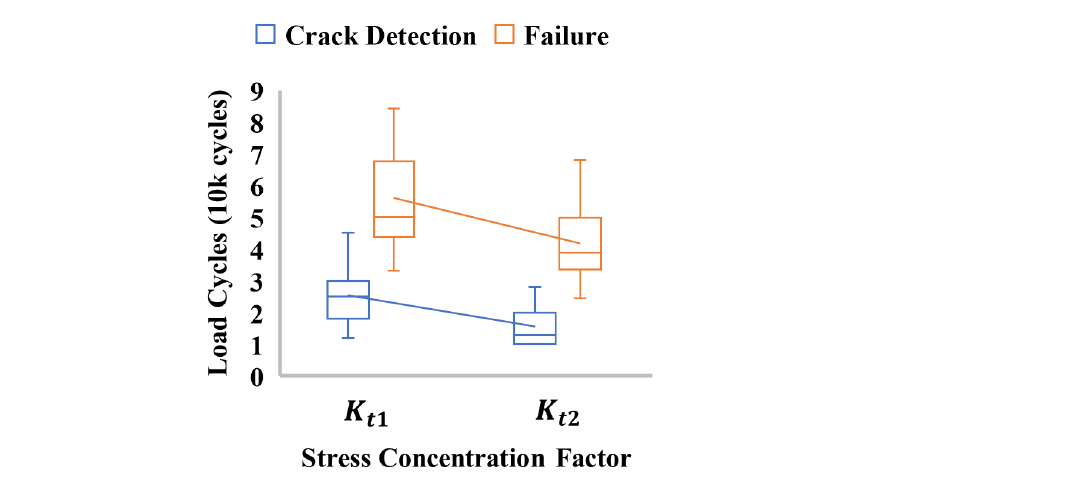
Figure 4. Comparison between the crack detection and failure instances for K t 1 and K t 2 in terms of the number of load cycles.